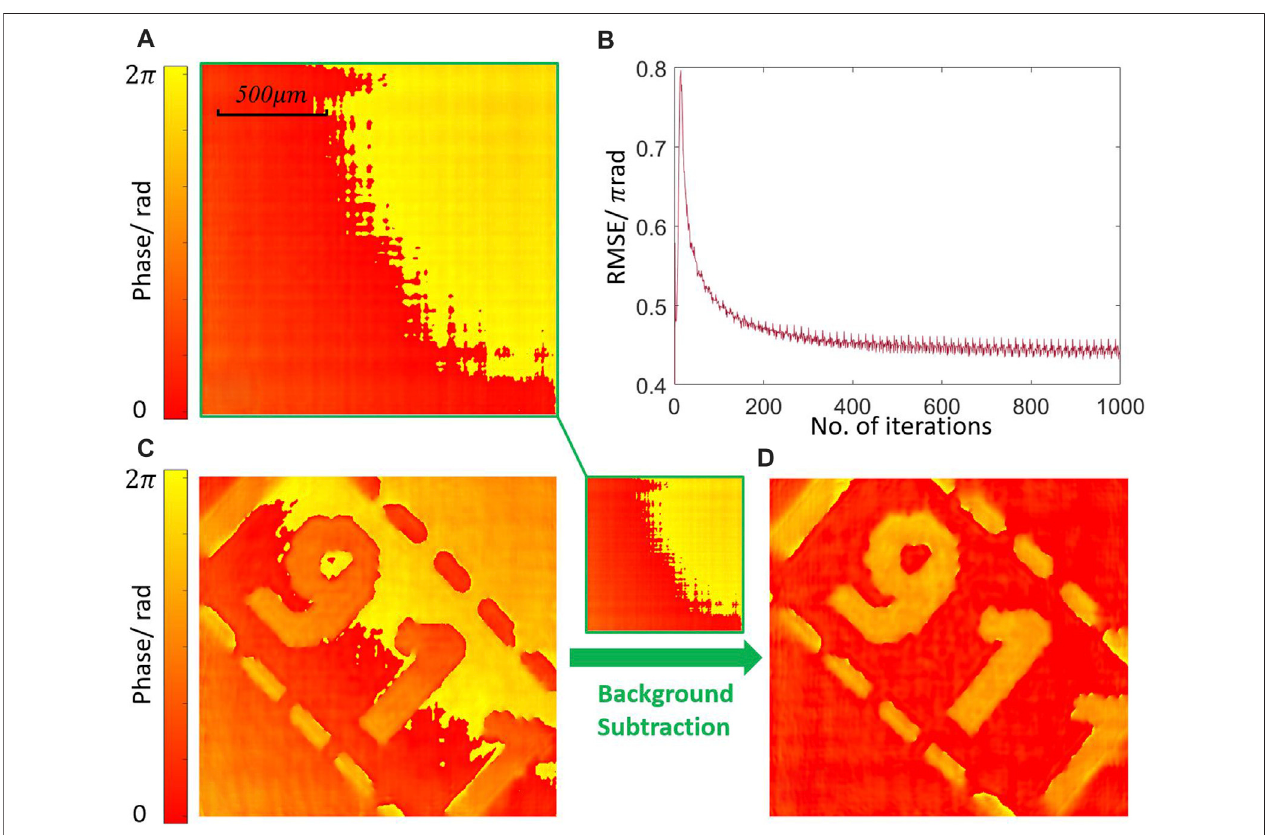
FIGURE7|(A) Reconstructed phase oftheilluminationinthe experiment usingthe ASPM method. (B) RMSE during reconstruction. (C) The reconstructedphase of the object with an illumination background. (D) Object phase with background subtraction.